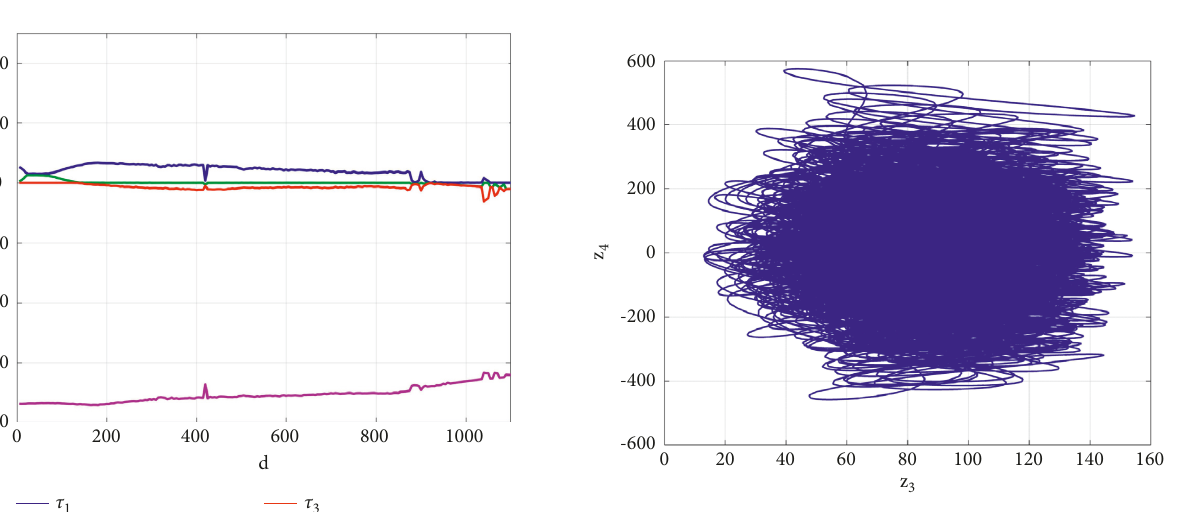
Figure 22: A hyperchaotic attractor of the model (1) for d � 40 and ( a, b,c ) � ( 25 , 8 , 90 )